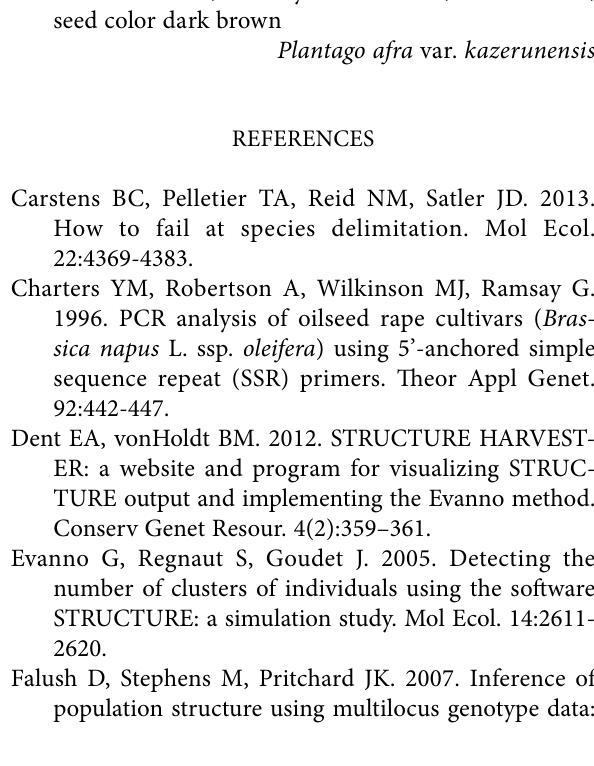
IUCN Red List category : Plantago afra var. kazerun- ensis has not yet been evaluated using IUCN Red